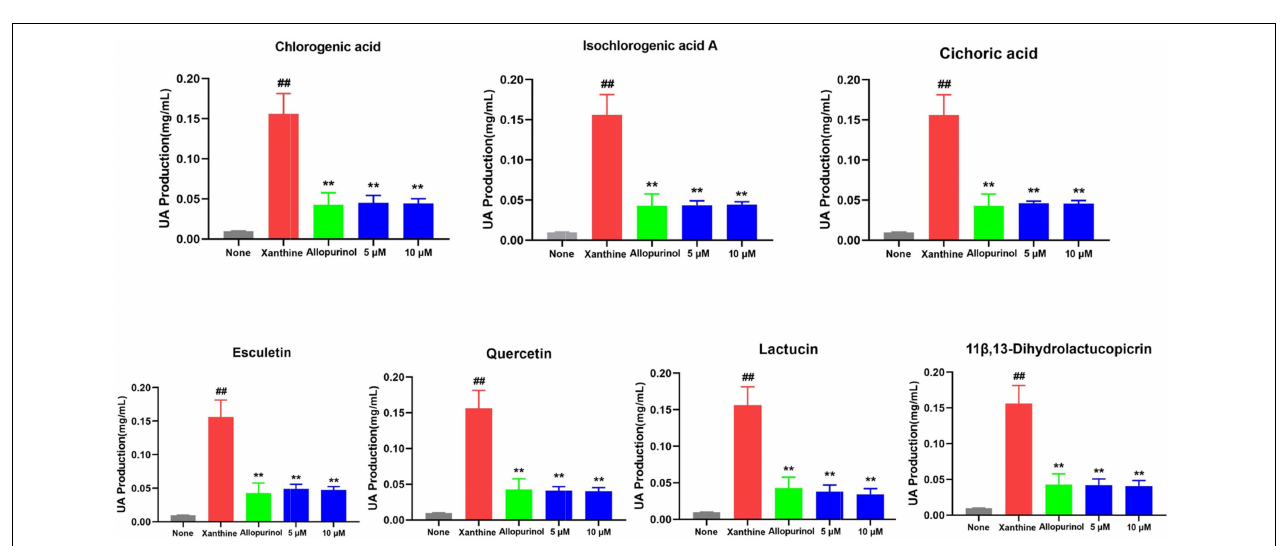
FIGURE 10 | Molecular docking analysis. (A) Molecular docking result of lactucin with TP53; (B) molecular docking result of quercetin with XDH; (C) molecular docking result of lactucin with ABCG2; (D) molecular docking result of esculetin with IL-6; and (E) molecular docking result of 11 β ,13-dihydrolactucopicrin with TNF.